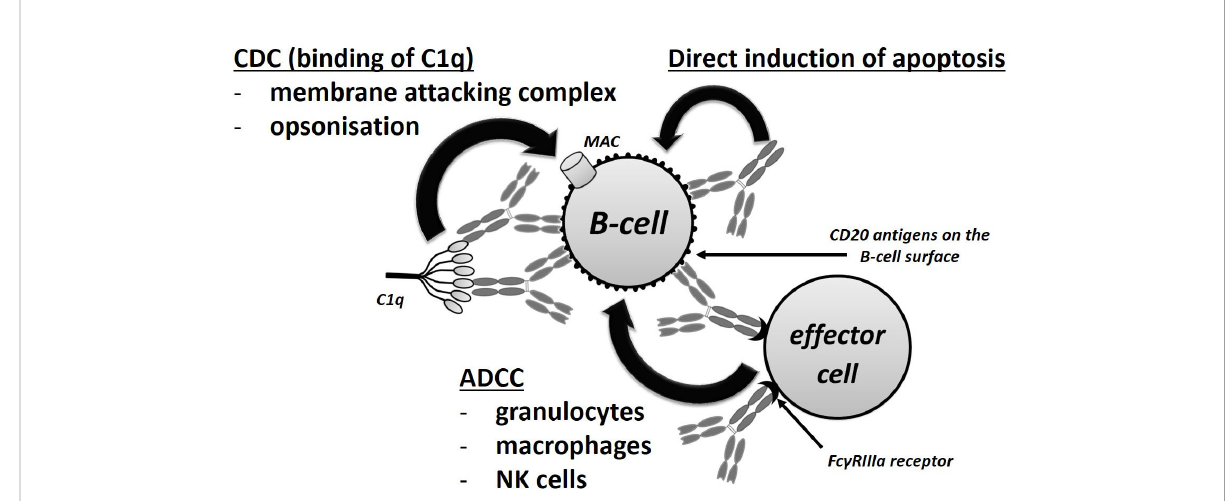
FIGURE 1 Mechanisms of action of rituximab. CDC, complement-dependent cytotoxicity; ADCC, antibody-dependent cellular